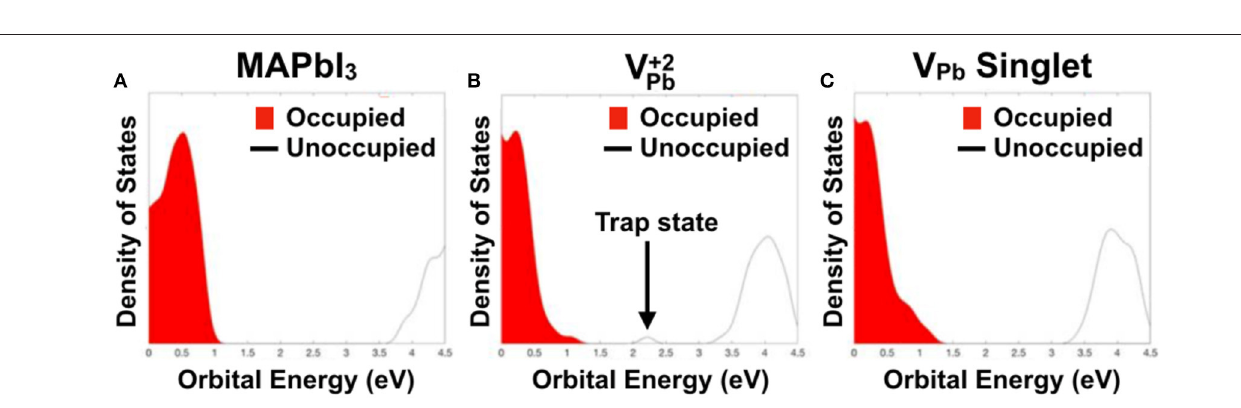
FIGURE 6 | DOS in MAPbI 3 , V Pb + 2 , and V Pb singlet. The trap state in V Pb + 2 appears. [Reprinted with permission from Vogel et al.